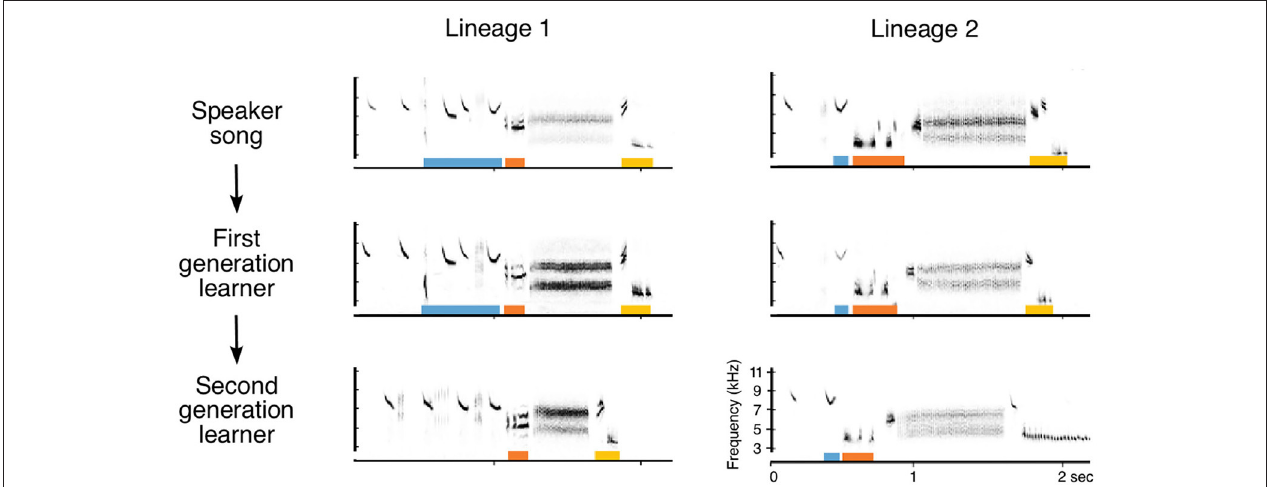
FIGURE 5 | Transmission of seeded songs in a wild population of Savannah sparrows. Songs including characteristics not recorded in the previous 35 years on Kent Island (colored bars below notes on sonograms) were presented through an array of speakers across several hectares of Savannah sparrow habitat in the summer and subsequent early spring. Different songs were used each learning cycle, so birds that were older than the first-generation learners could not have learned the songs from speakers. The patterns of transmission of the novel seeded songs can be followed (After Mennill et al.,